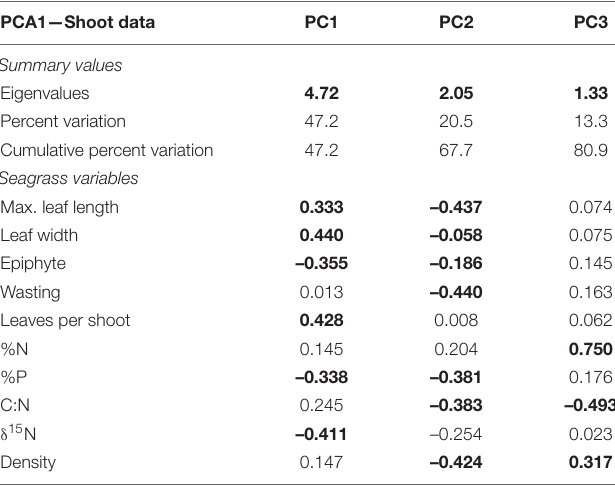
TABLE 2 | Results from the Principal Components Analysis (PCA) carried out using available data from Welsh sites and Isles of Scilly for nutrient data, shoot metrics, and